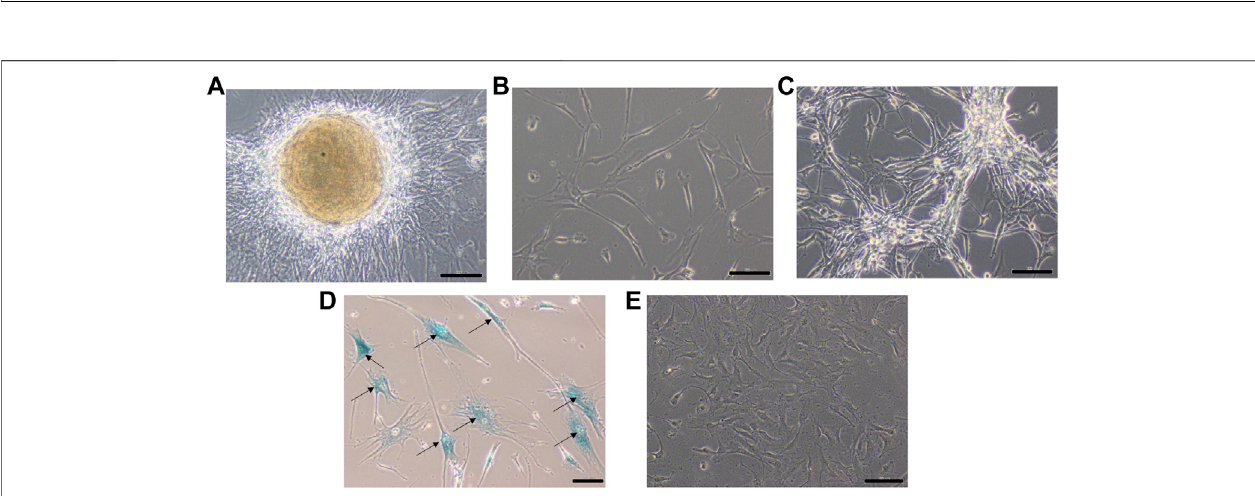
FIGURE 3 | Phase contrast picture of DIG cell culture at different days of growth. Scale bars represent 100 μ m. Morphologically, the cultures comprise a mixed populationofcellsincludingneuronal,glialand astrocyte cells. (A) :Tissueoutgrowth ofcellsfromasmallpieceoftissueadherenttothetissueculturevessel. (B) :Diffuse cell growth at day 6. (C) : Dense growth of cells at day 10. (D) : Human fi broblast cells at passage 5 showing intense blue stain with beta-galactosidase indicating senescence. (E) : DIG cells in culture at passage 10 showing a lack of senescence.